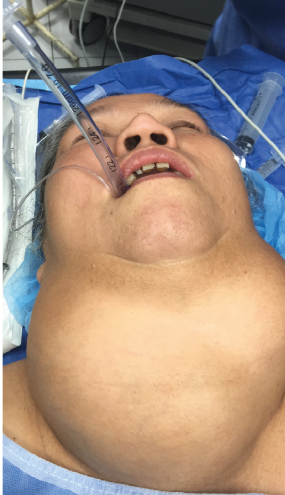
Figure 5: Neglected goiter, a preoperative view.